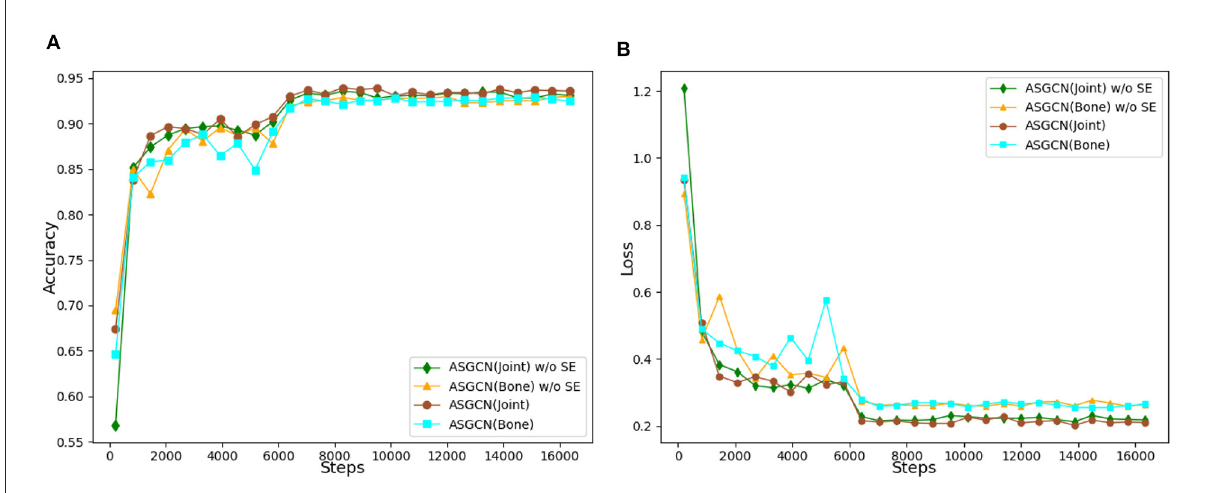
FIGURE8 (A) Accuracy comparison of spatial graph convolution layer with or without SE block. (B) Loss function comparison of spatial graph convolution layer with or without SE